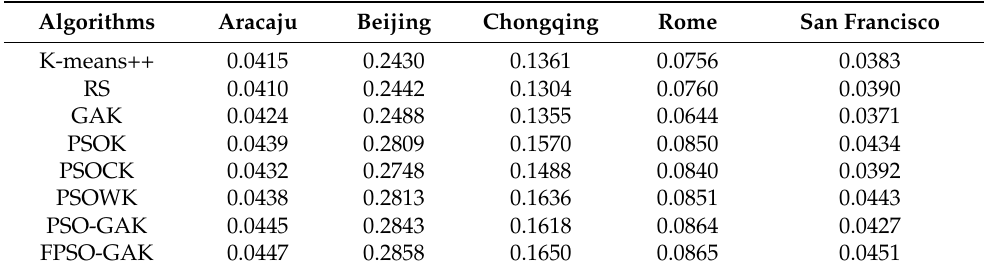
Table 6. Average degree of separation of 8 algorithms trained 20 times in 5 GPS data sets. Algorithms